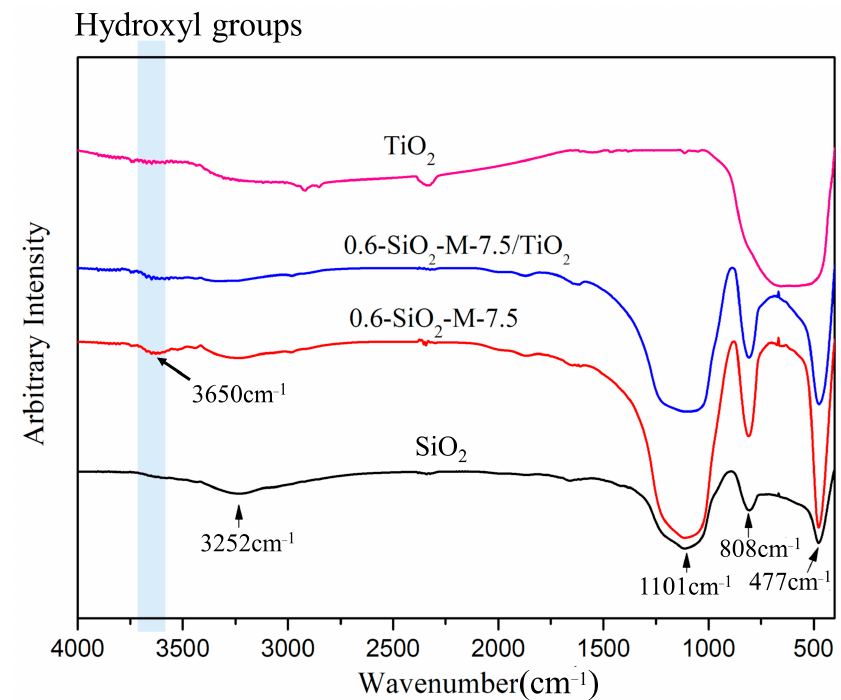
Figure 10. Infrared spectra of SiO 2 , 0.6-SiO 2 -M-7.5, 0.6-SiO 2 -M-7.5/TiO 2 , and TiO 2 .